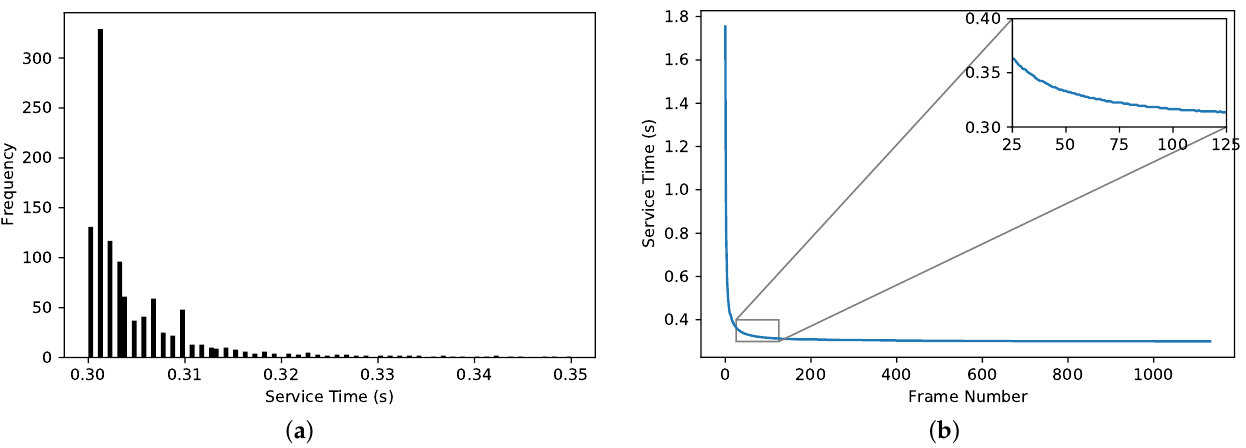
Figure 7. Measurement of the achieved service time—time to detect objects in a frame. ( a ) The relationship frame number and the time it takes (service time) to recognise objects in each frame. ( b ) Histogram of the achieved service time. Most frames were processed within 0.30–0.31 s time